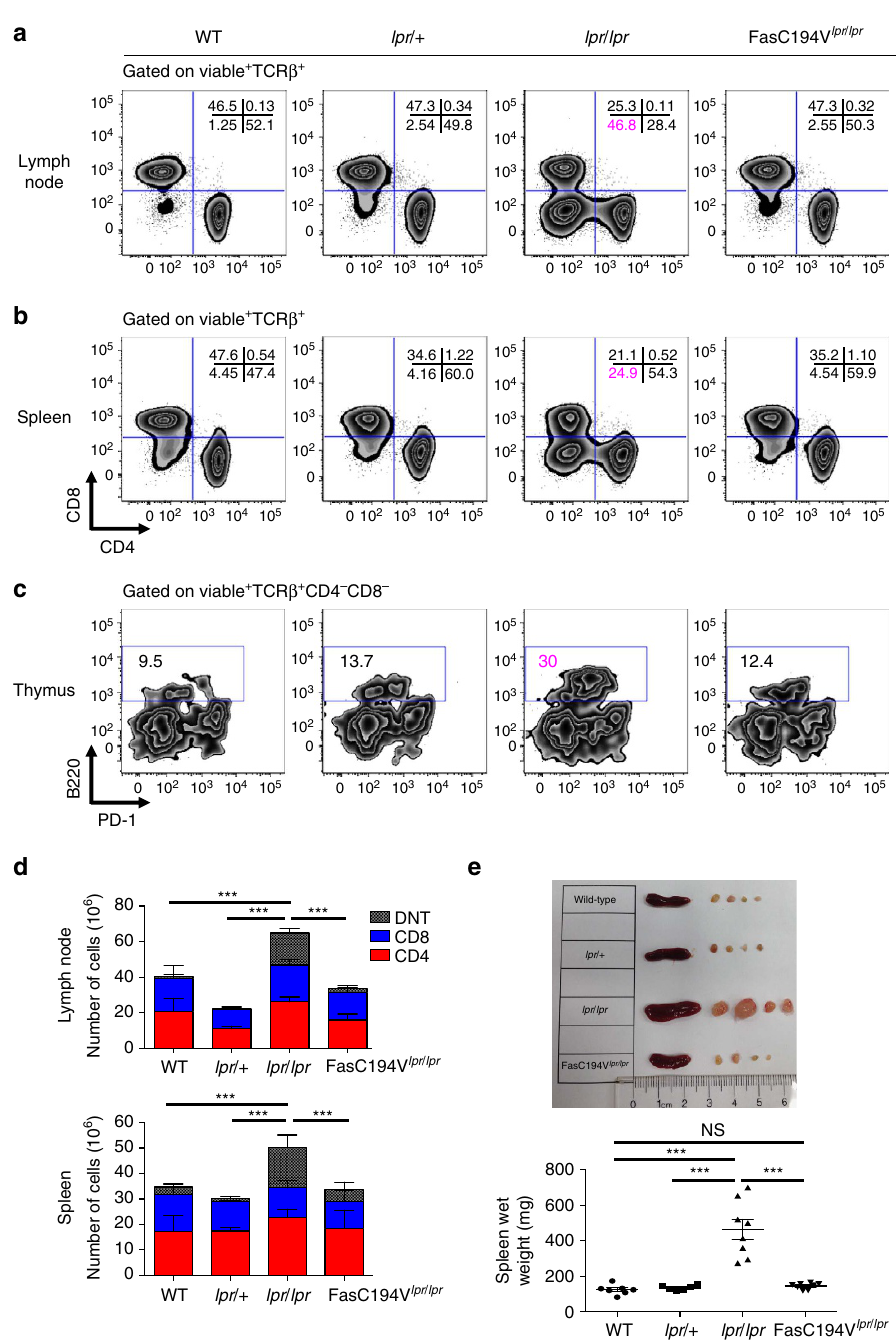
Figure 4 | Fas C194V prevents lymphoaccumulation associated with Fas deficiency. Lymph nodes ( a ), spleens ( b ) and thymi ( c ) of age-matched WT, lpr/ þ , lpr/lpr and FasC194V lpr/lpr mice were isolated, stained for the indicated surface markers and analysed by flow cytometry, with quantitation and statistical analysis (unpaired t -test) of DN T cells in d . Data are compiled from three independent experiments, represented as mean ± s.e.m. *** P r 0.001. Viable cells were gated TCR b þ for both lymph nodes ( a ) and spleen ( b ) before analysis. Thymic cells ( c ) were gated TCR b þ CD4 (cid:2) CD8 (cid:2) on the viable population before analysis. Mice were B 30 weeks of age ( n Z 12 for each genotype). ( e ) Representative lymph nodes and spleens of the indicated age-matched genotypes, with spleen wet weights. Image representative of two independent experiments. Mice were B 30 weeks of age. Quantitation is cumulative of three independent experiments ± s.e.m. Mann–Whitney test was used for statistical analysis. *** P r 0.001. NS ¼ not